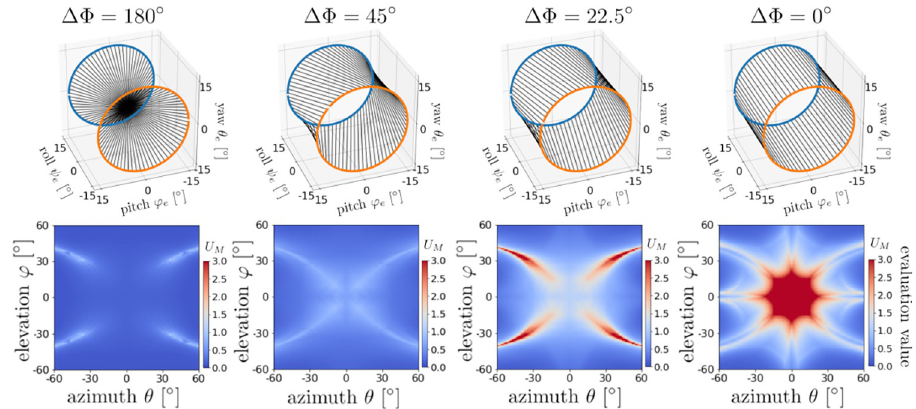
Fig 11. Effect of phase difference of ear motions on direction detection performance. In the upper panels, blue line indicates the left ear’s orbit given by ð c l ; φ l ; y l Þ ¼ ð C ; C cos ð 2 p f t Þ ; C sin ð 2 p f t ÞÞ , and orange line does the right ear’s e e e e e orbit ð c r ; φ r ; y r Þ ¼ ð(cid:0) C ; C cos ð 2 p f t þ DF Þ ; C sin ð 2 p f t þ DF ÞÞ , respectively. Black straight lines connect e e e e e simultaneous points of the left and right ears’ orbits with the phase difference Δ F . In particular, the ear motion with Δ F = 180˚ is [ CONST , COS , SIN ] and the ear motion with Δ F = 0˚ is [ CONST , COS , SIN ]. For motions with Δ F between 45˚ and 180˚, good-quality direction detection performance is achieved.